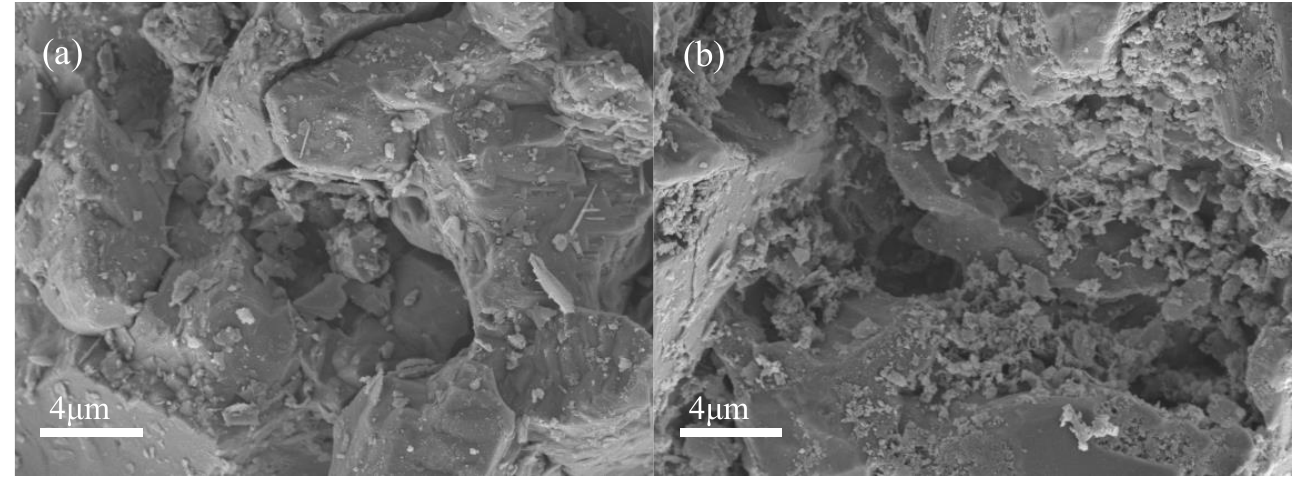
Figure 7. SEM images of ITs before ( a ) and after ( b ) phosphate adsorption. The adsorption isotherm describes the adsorption processes at the solid–liquid inter- faces and can be studied to calculate the adsorption capacity and explain the adsorption mechanism [53,54]. In this study, the adsorption data were fitted according to the Langmuir and Freundlich isotherm models. The linear form of the Langmuir isotherm model can be expressed as follows